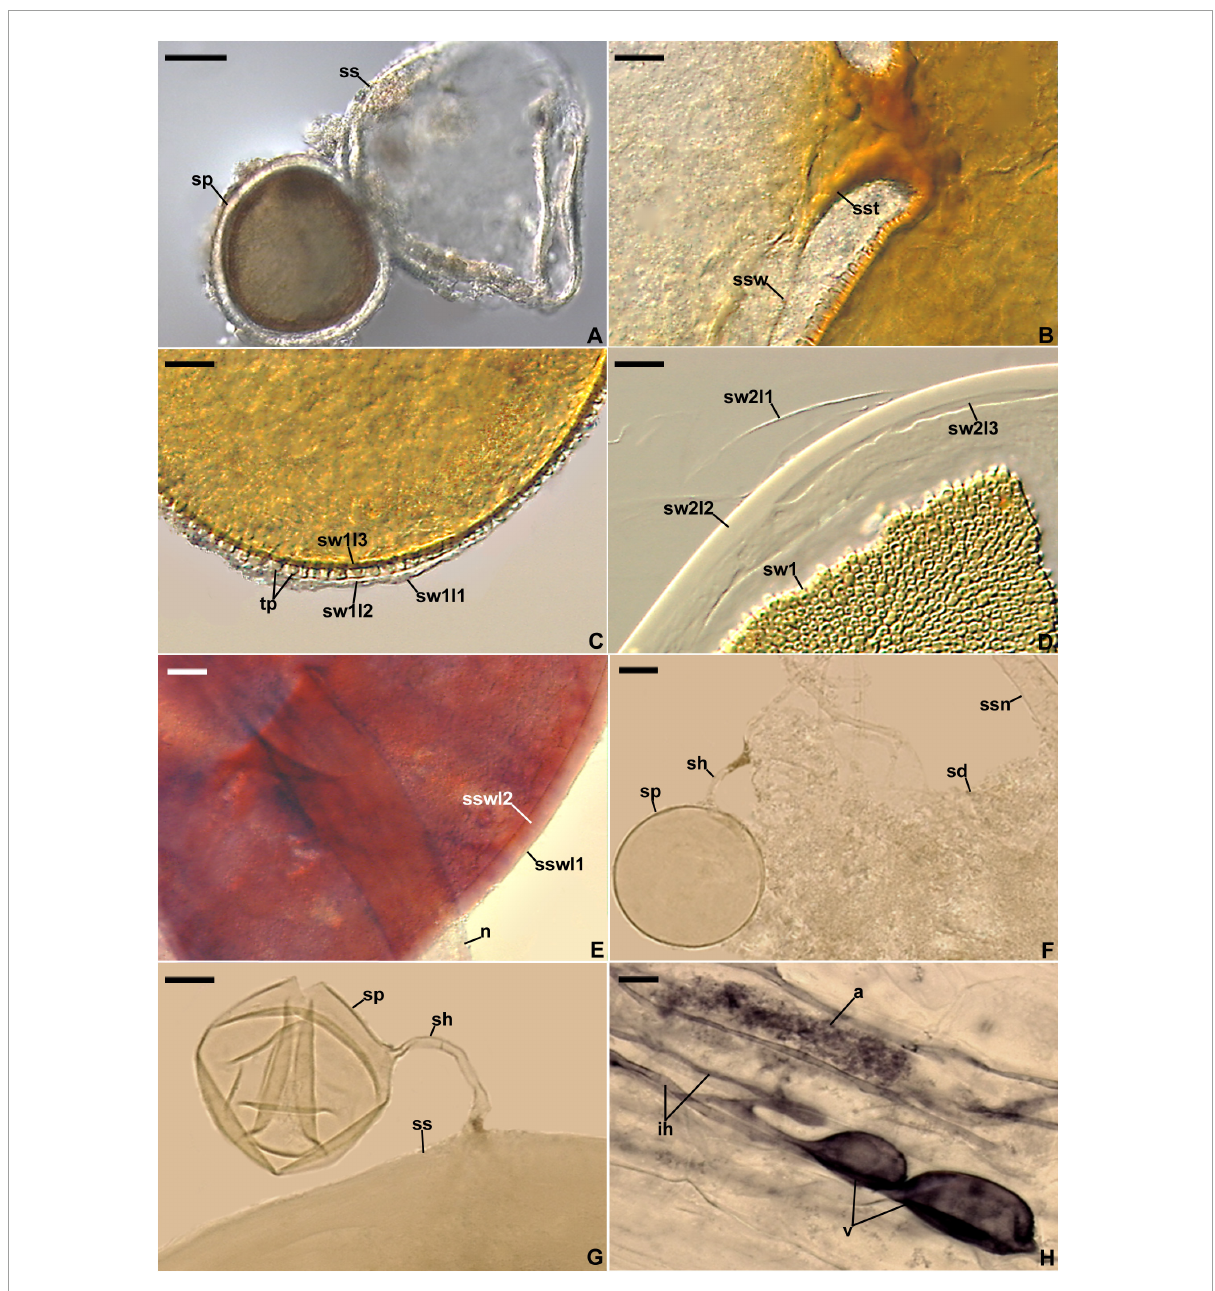
FIGURE4 Entrophospora infrequens . (A) Entrophosporoid morph with spore (sp) formed inside the sporiferous saccule (ss). (B) Funnel-shaped structure, continuous with spore wall 1 layer 3, supporting the sporiferous saccule wall (ssw). (C ) Spore wall 1 layers (sw1l) 1–3; swl1 is almost completely sloughed off; tooth-shaped projections (tp) in cross-view are visible. (D) Spore wall 1 (sw1) and spore wall 2 layers (sw2l) 1–3. (E) Sporiferous saccule wall layers (sswl) 1 and 2, and the neck (n) of sporiferous saccule. (F) Juvenile glomoid spore (sp) with subtending hypha (sh) developed from the sporiferous saccule neck (ssn); soil debris (sd) are indicated. (G) Juvenile glomoid spore (sp) with subtending hypha (sh) developed from sporiferous saccule (ss). (H) Mycorrhiza with arbuscule (a), vesicles (v), and intraradical hyphae (ih). (A–D , F–H) Spores and mycorrhizal structures in PVLG. (E) Sporiferous saccule in PVLG+Melzer’s reagent. (A–H) Differential interference microscopy. Scale bars: (A) = 50 µ m, (B–H) = 10 µ m.